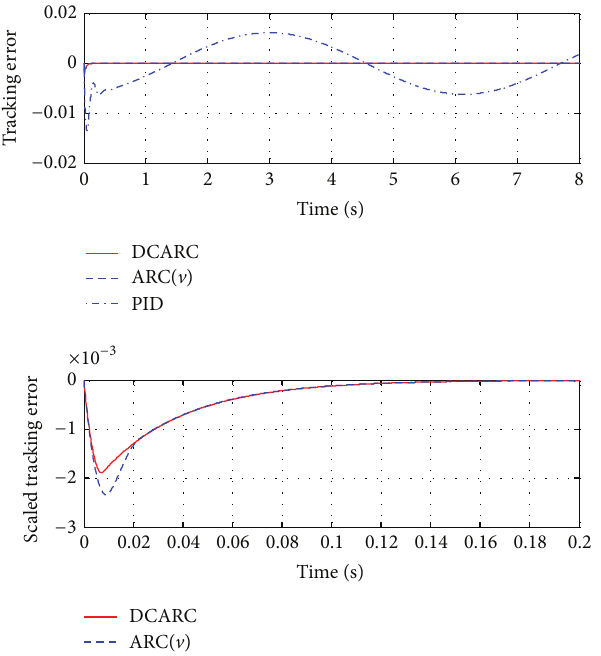
Figure 2: Tracking error in the presence of parametric uncertainty only.